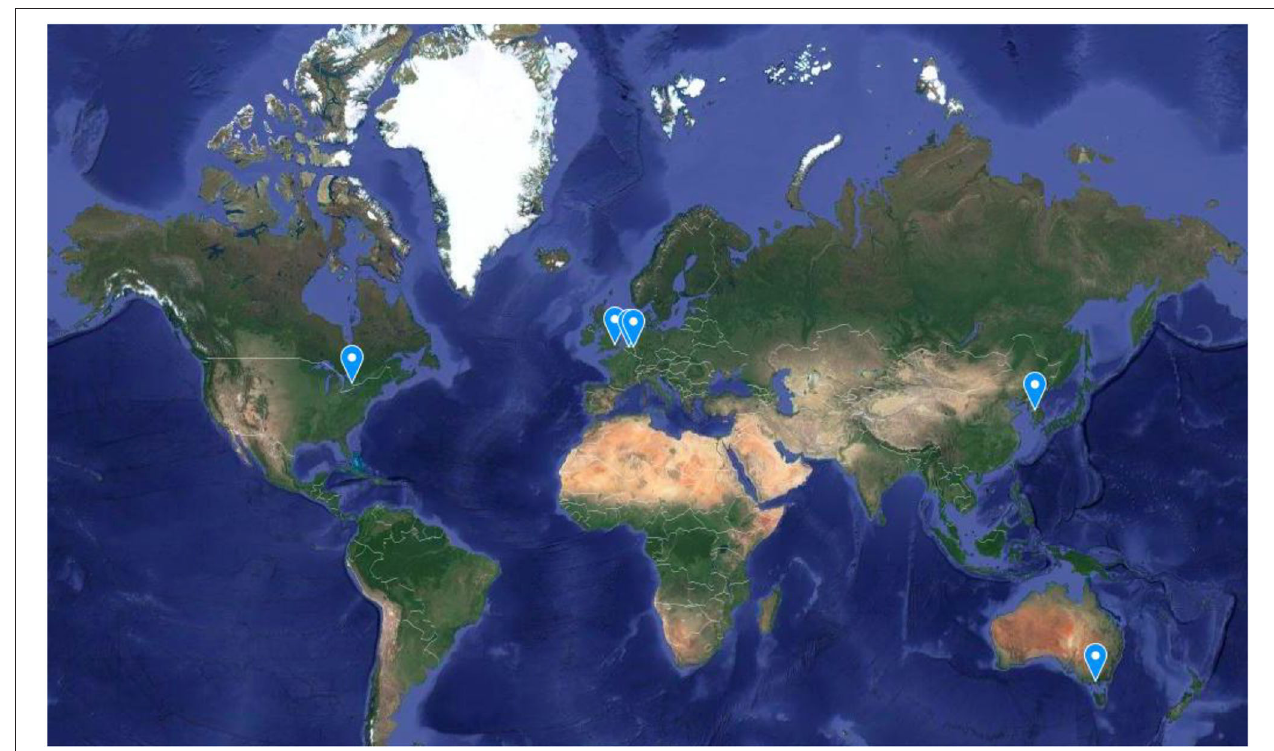
FIGURE 1 | Participating